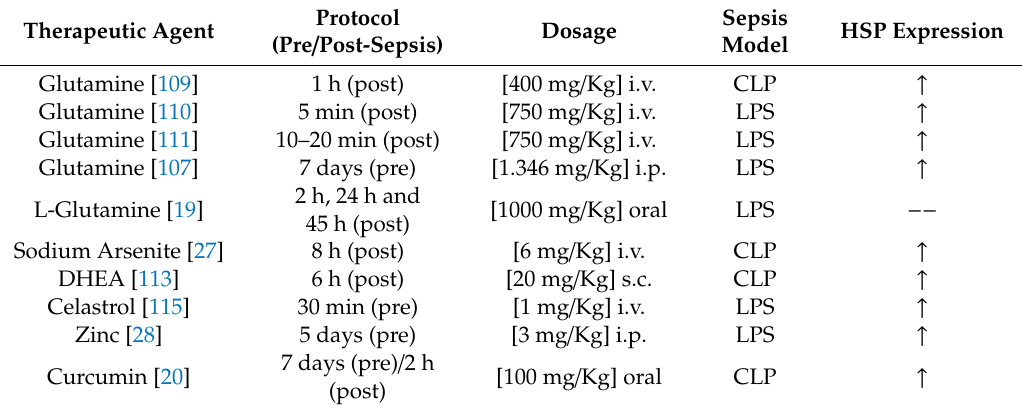
Table 2. Therapeutic agents used in experimental models of sepsis as HSP